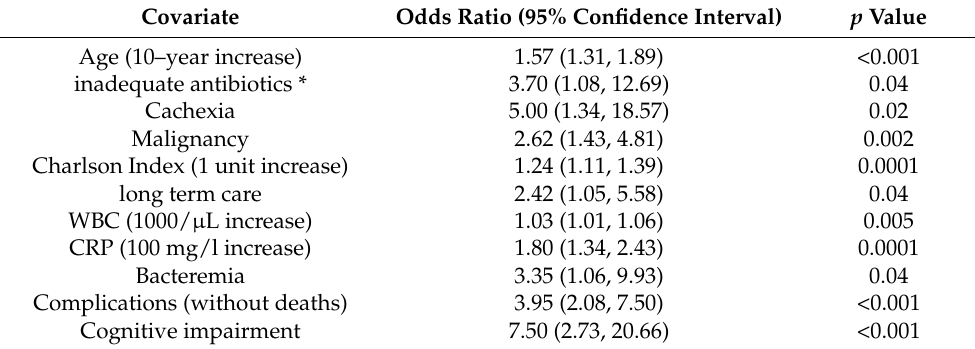
Table 5. List of independent death predictors in a multivariate logistic regression model.